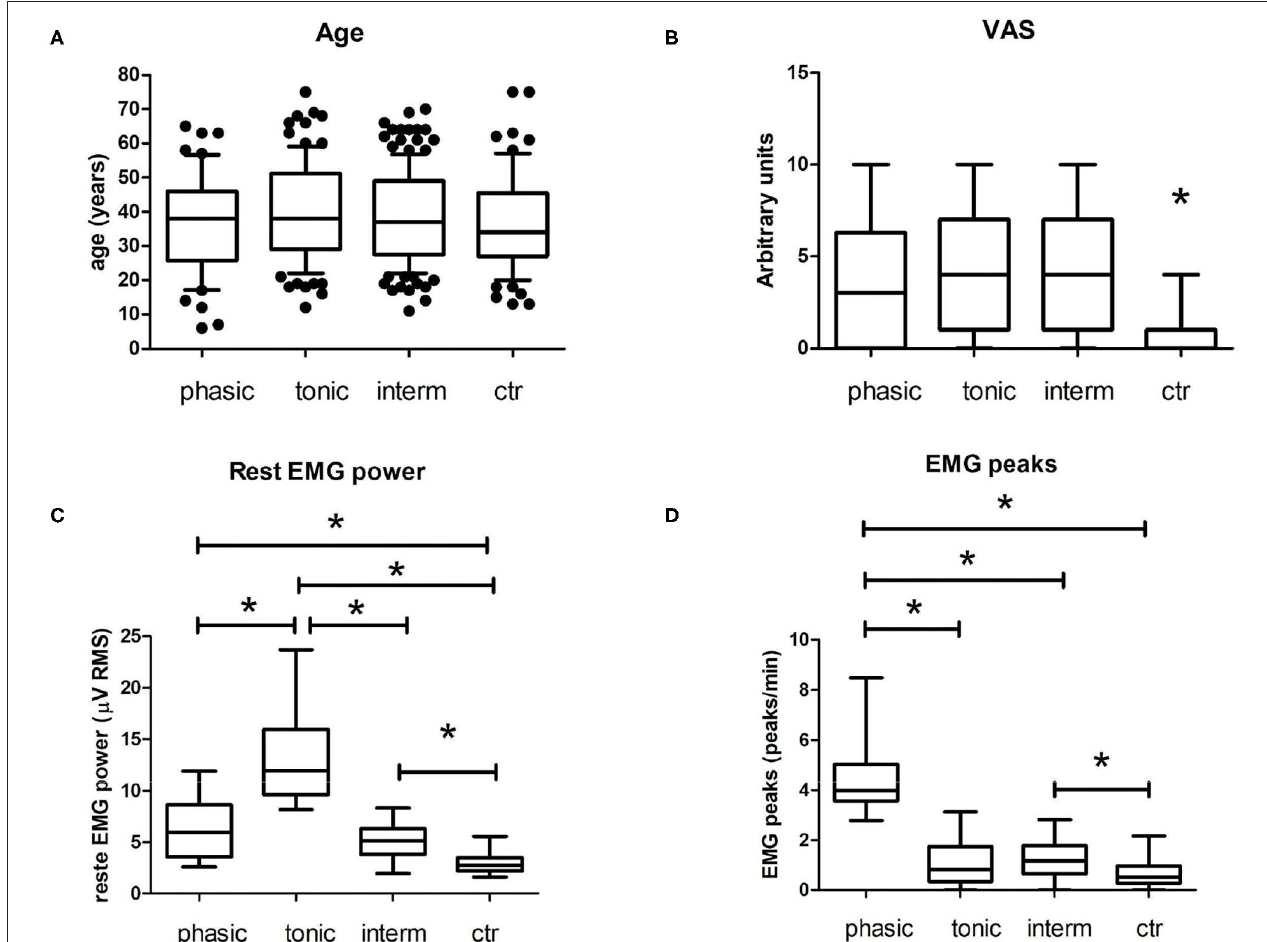
FIGURE 4 | Main results of intergroup analyses. (A) Age of subjects included in each group. These boxplots represent median (horizontal line) and the 10th and 90th percentiles. Black dots represent points out of this range (outliers). There is no specific skewing for children or elderly in these groups. Also, there is no statistically significant difference between them ( p > 0.05, One Way ANOVA with Tukey’s Multiple Comparison post-hoc test). (B) Boxplot of self-reported pain in a Visual Analogical Scale (VAS, arbitrary units) from 0 (no pain) to 10 (intense pain). Ctr, control group. Ctr was different from all other groups. (C) Rest EMG Power. The tonic subgroup has a higher rest EMG power compared to other groups. (D) EMG peaks. The phasic subgroup has a higher peak/min range compared to other groups; * p < 0.05, Kruskal–Wallis with Dunn’s Multiple Comparison post-hoc test; Data with normality checked with Kolmogorov–Smirnov test. The boxplots in (B–D) represent median (horizontal line) and minimum and maximum values.